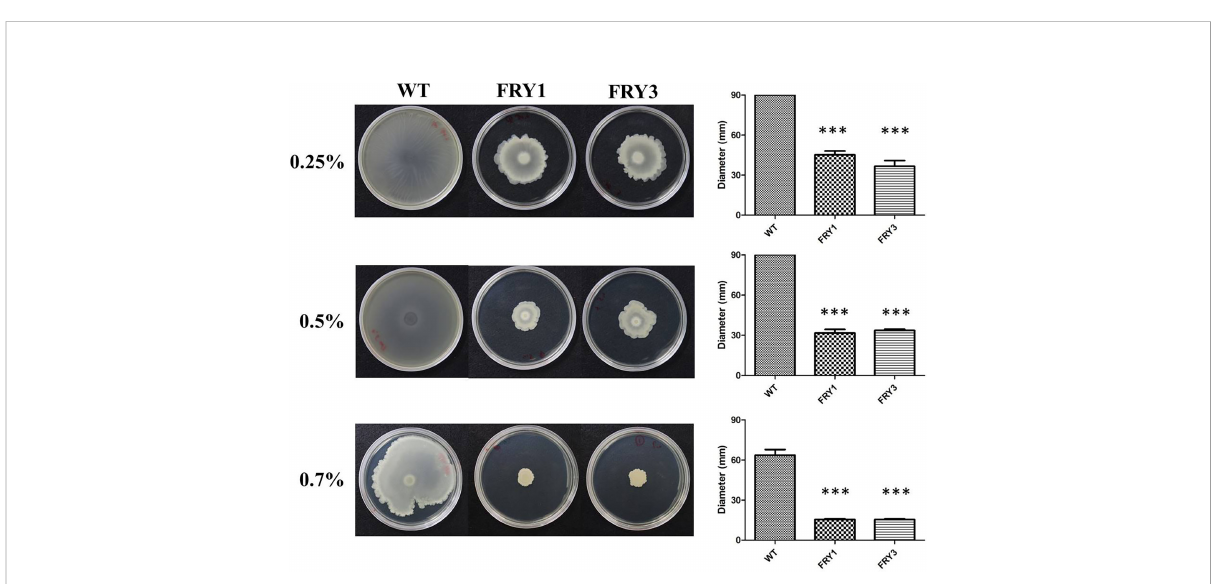
FIGURE 8 The D srf mutants showed attenuated swarming motility. Five microliters of strains (OD 600 = 1) were inoculated on 0.25%, 0.5% or 0.7% solid LB agar at 37°C for 48 h. P values were calculated by t -test, “ *** ” represents P < 0.001 as compared to the